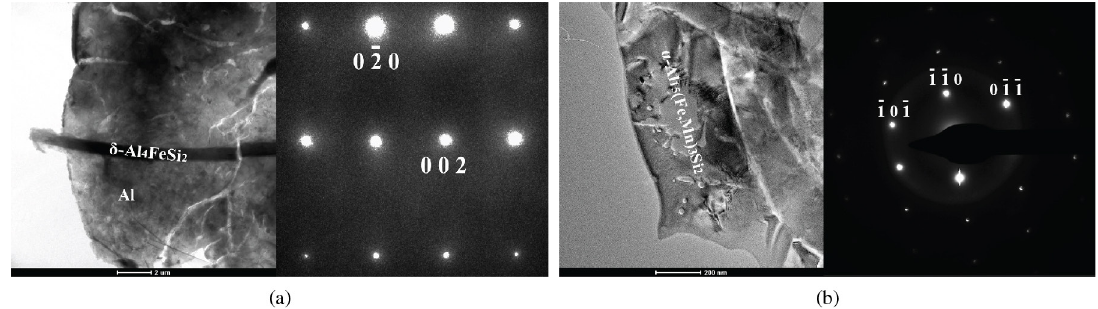
Figure 7. Bright-field TEM images of Fe-rich phases in A2 alloy: (a) SAPD of acicular δ -Al axis; (b) SAPD of blocky α -Al